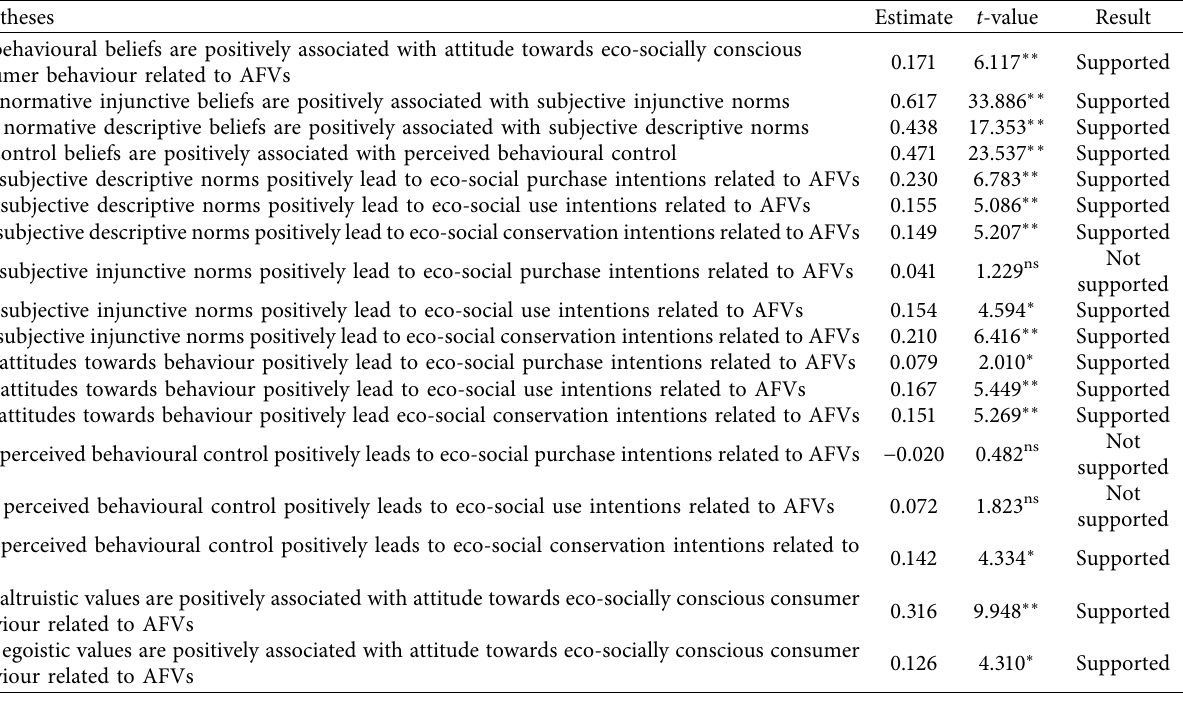
Table 6: Summary of results of